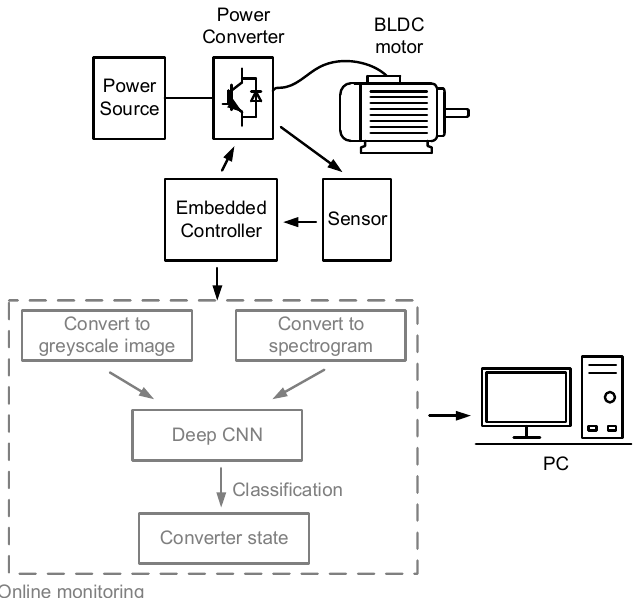
Figure 6. Overview of the monitoring system.